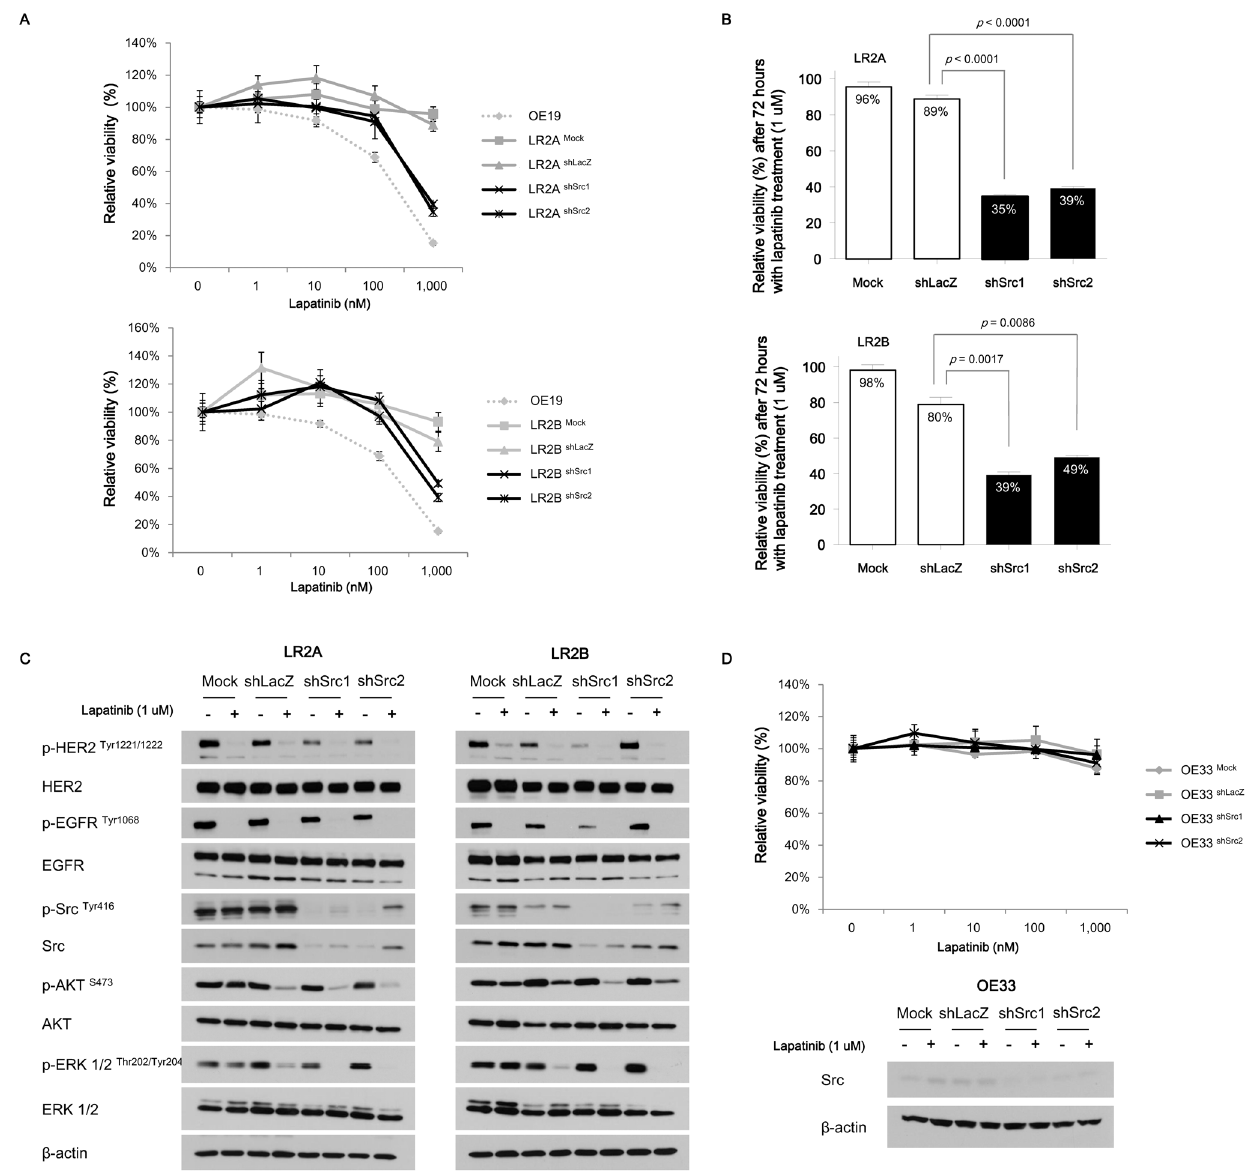
Figure 3. Effects of RNAi-mediated silencing of Src on lapatinib sensitivities and responses of signalling proteins. A, Lapatinib sensitivity curves for LR2A and LR2B subclones transduced with shSrc or control (shLacZ). The lapatinib sensitivities were restored after RNAi silencing of Src in the two LR subclones. The calculated values of IC 50 were following; 200 nM for parental OE19; . 1,000 nM for LR2A Mock , LR2A shLacZ , LR2B Mock , and LR2B shLacZ ; 432.8 nM and 403.7 nM for LR2A shSrc1 and LR2A shSrc2 , respectively; 276.6 nM and444.2 nM for LR2B shSrc1 and LR2B shSrc2 , respectively. Values were presented as relative cellular viability relative to vehicle-treated controls with the mean 6 S.E. of quadruplicate from a representative experiment. In the lapatinib sensitivity curve for LR2A and its subclones transduced with lentiviral vectors, the p value was 0.121 for mock vs control (shLacZ), , 0.0001 for control vs shSrc1, and , 0.0001 for control vs shSrc2. In the lapatinib sensitivity curve for LR2B and its subclones transduced with lentiviral vectors, the p value was 0.764 for mock vs control, , 0.0001 for control vs shScr1, and 0.012 for control vs shSrc2. The p values were calculated by two-way ANOVA. B, Relative cell viability after 1 m M concentration of lapatinib treatment in two LR subclones with or without RNAi-mediated silencing of Src . The p values were calculated by two-tailed t -test. LR subclones transduced with shSRC restored lapatinib sensitivities. Values were presented as relative cellular viability relative to vehicle-treated controls with the mean 6 S.E. of quadruplicate from a representative experiment. C, Immunoblots showing changes of various signalling proteins after treatment with 1 m M concentration of lapatinib in two LR subclones with or without RNAi-mediated silencing of Src . Proteins were harvested 4 hours after lapatinib or vehicle treatment. D, Lapatinib sensitivity in OE33 cells following regarding RNAi transduction targeting Src . Values were presented as relative cellular viability relative to vehicle- treated controls with the mean 6 S.E. of quadruplicate from a representative experiment. Proteins were harvested 4 hours after lapatinib or vehicle treatment. There was no statistical significance between cell lines in terms of lapatinib sensitivity (0.070 for mock vs control [shLacZ], 0.520 for control vs shSrc1, and 0.753 for control vs shSrc2, respectively). The p values were calculated by two-way ANOVA. doi:10.1371/journal.pone.0109440.g003 LR subclones (Figure 3C). These data indicate that, in these Src- required to completely block pathologic mitogenic signalling. The mutant LR subclones, blockade of both Src and ERBB2 is phosphorylations of AKT and ERK were slightly downregulated